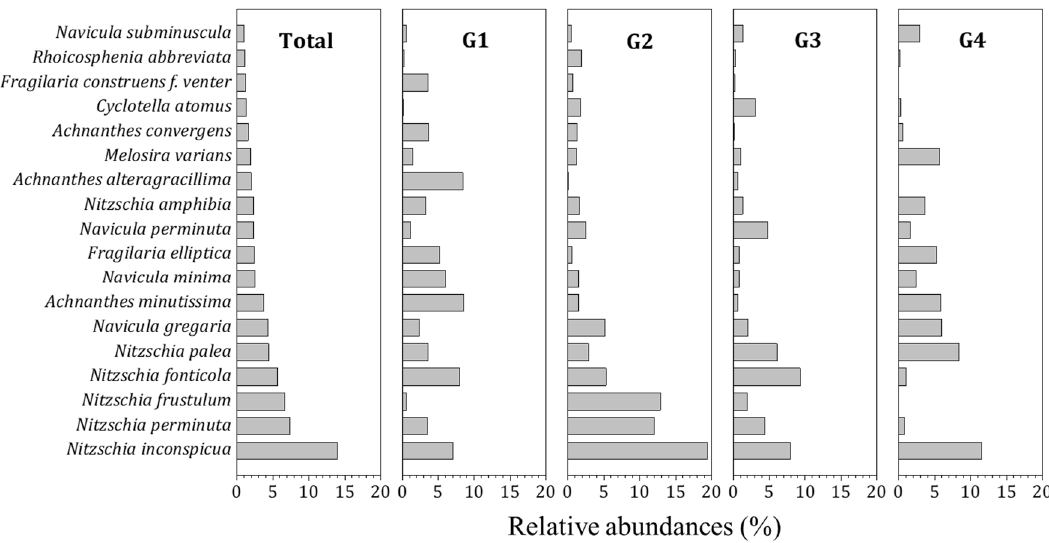
Figure 3. Relative abundances (%) of major epilithic diatom species observed in four groups in Korean estuaries between 2009 and 2016. The dominant species comprise those over the 0.5% of the total abundance in each group.